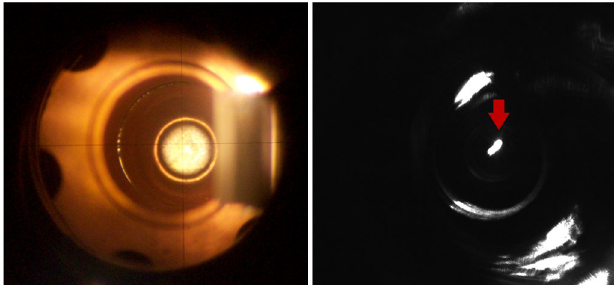
FIG. 11. Visible light and UV images of the cathode, taken through the end-of-line window. The cathode appears off center due to misalignment of the tripod supporting the telescope. The blurred square object in the visible light image is the in-vacuum laser mirror. The UV image shows the location of the drive laser on the niobium cathode, indicated by the red arrow.